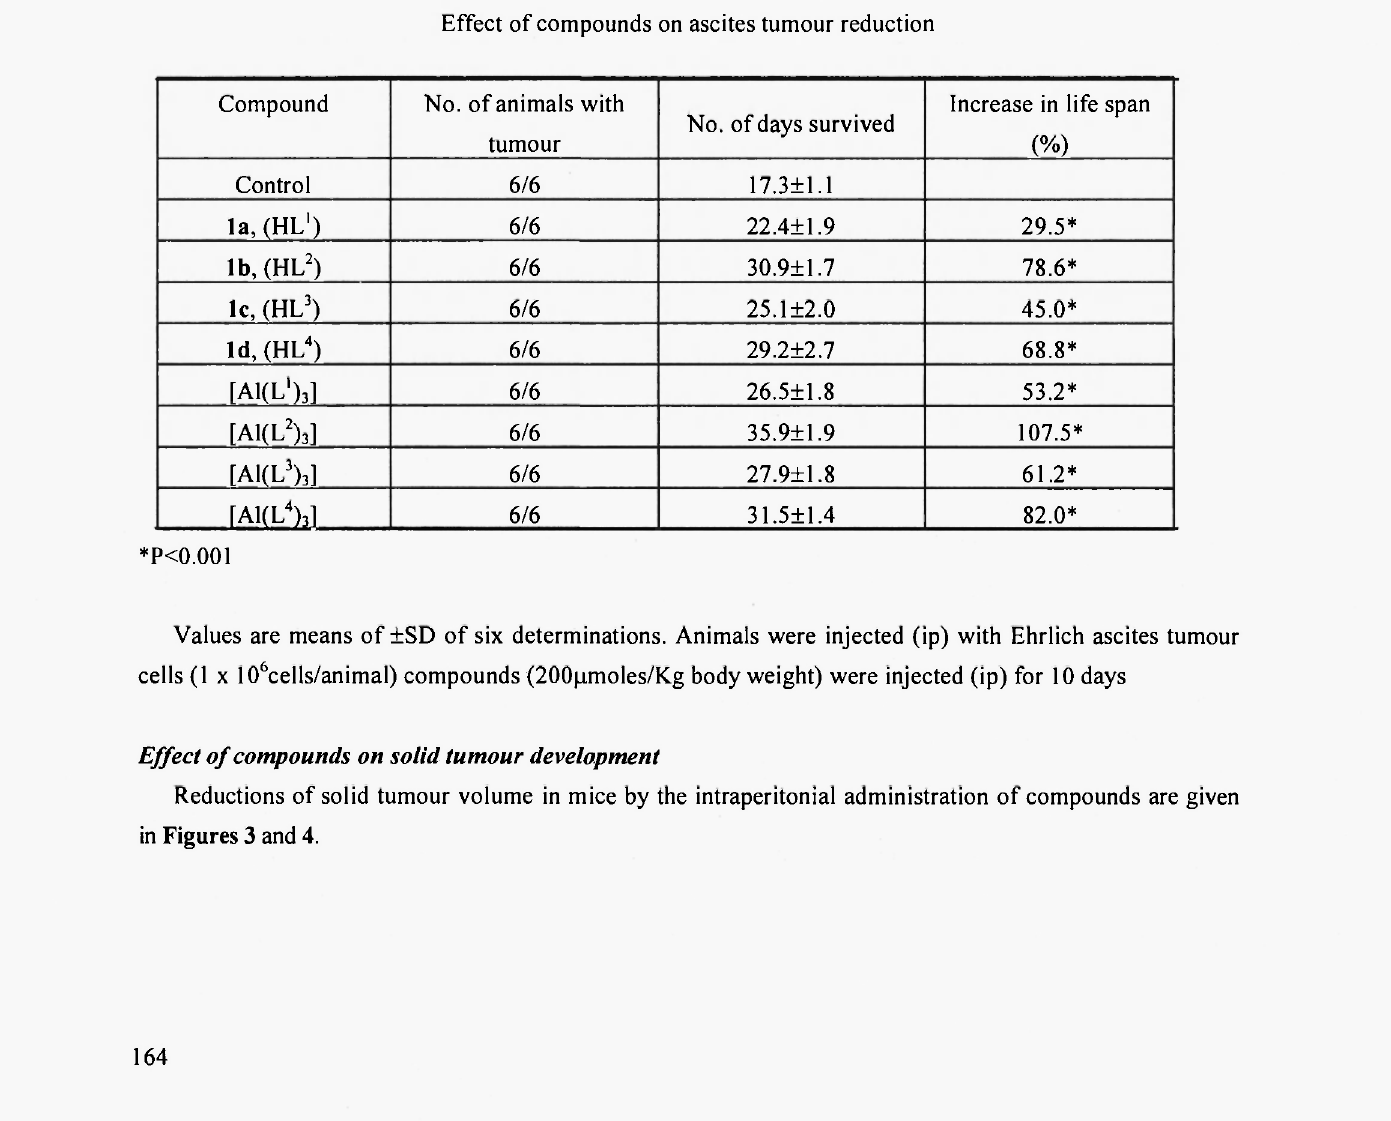
Effect of compounds on ascites tumour